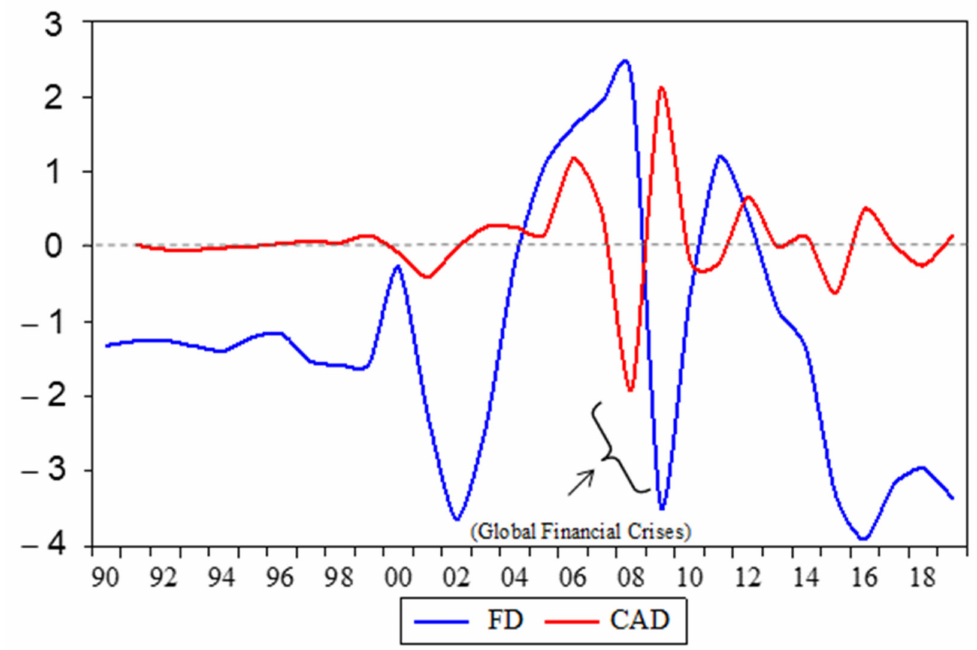
Figure 2. Trends of fiscal and current account deficits in